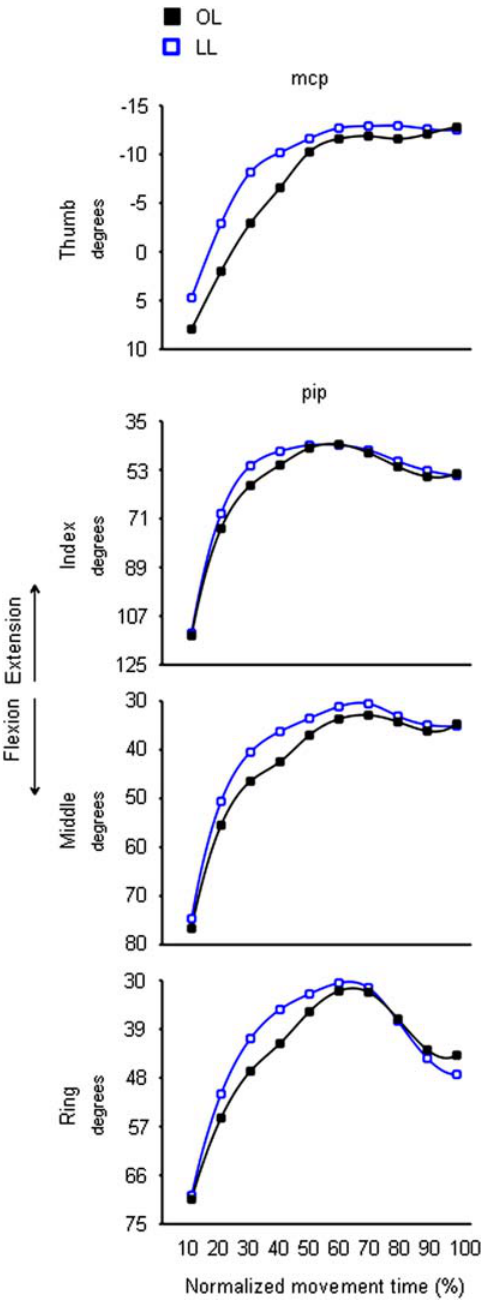
Figure 5. Time course of finger motion during reaching for the large target either in the absence or in the presence of an odour evoking a large object. Each trace corresponds to the average angular excursion of a representative subject (Subject 15) for the mcp joint of the thumb and the pip joint of the index, middle, and ring fingers when performing the ‘OL’ (black squares) and the ‘LL’ (blue squares) conditions. Positive values correspond to finger flexion whereas negative values correspond to finger extension. OL=Odourless air-Large target; LL=‘Large’ odour-Large target.